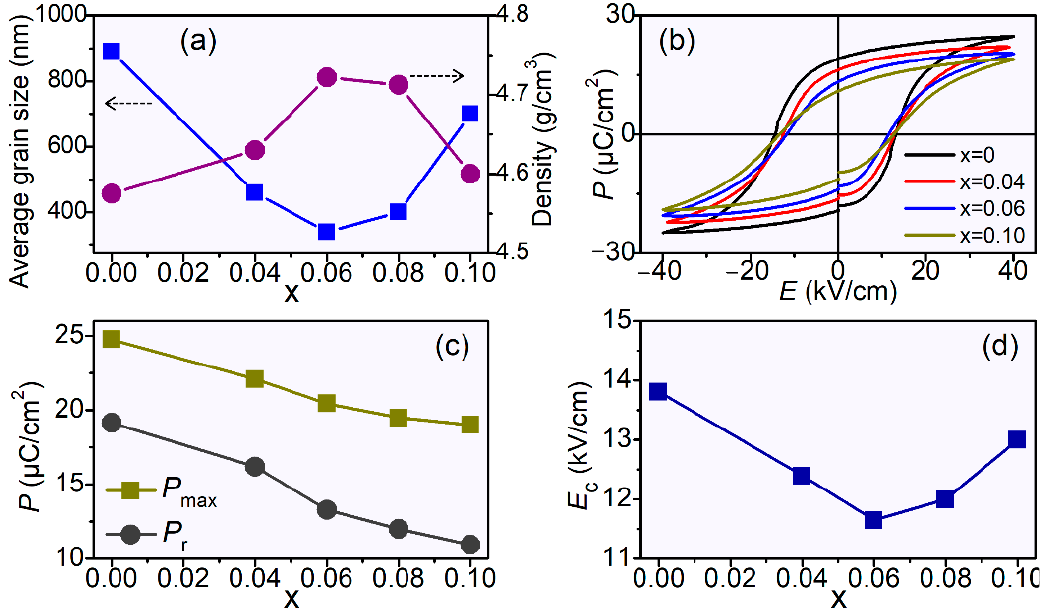
Figure 3. ( a ) Evolution of average grain size as a function of x for KNNS x -BNN ceramics. ( b ) Composition-dependent P - E loops of KNNS x -BNN ceramics. Evolution of ( c ) P max and P r and ( d ) E c as a function of x for KNNS x -BNN ceramics.